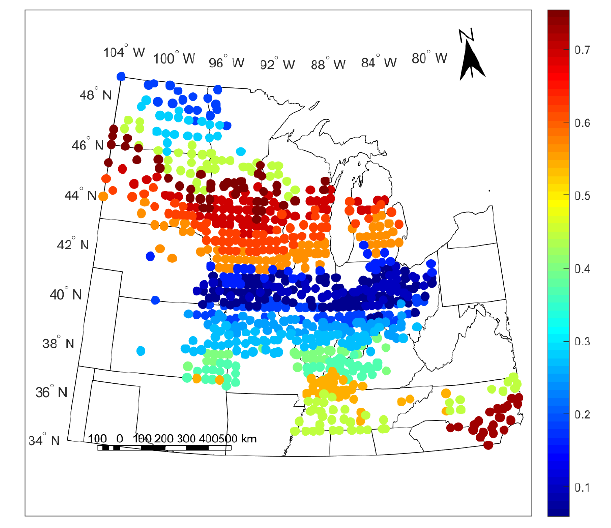
Figure 5. LOO yield prediction R 2 values by cluster for the 20-cluster weather-based clustering calibration.